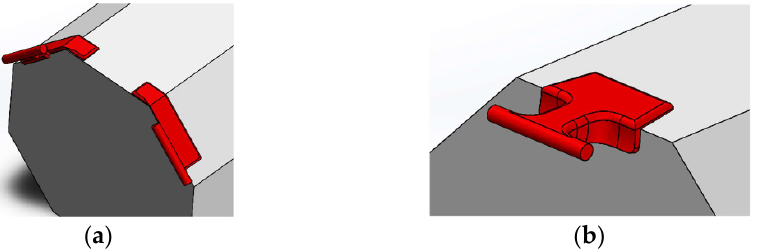
Figure 6. Detail of the clamps: one side of the package is constrained by two clamps ( a ), and the opposite side is constrained by a single clamp ( b ).